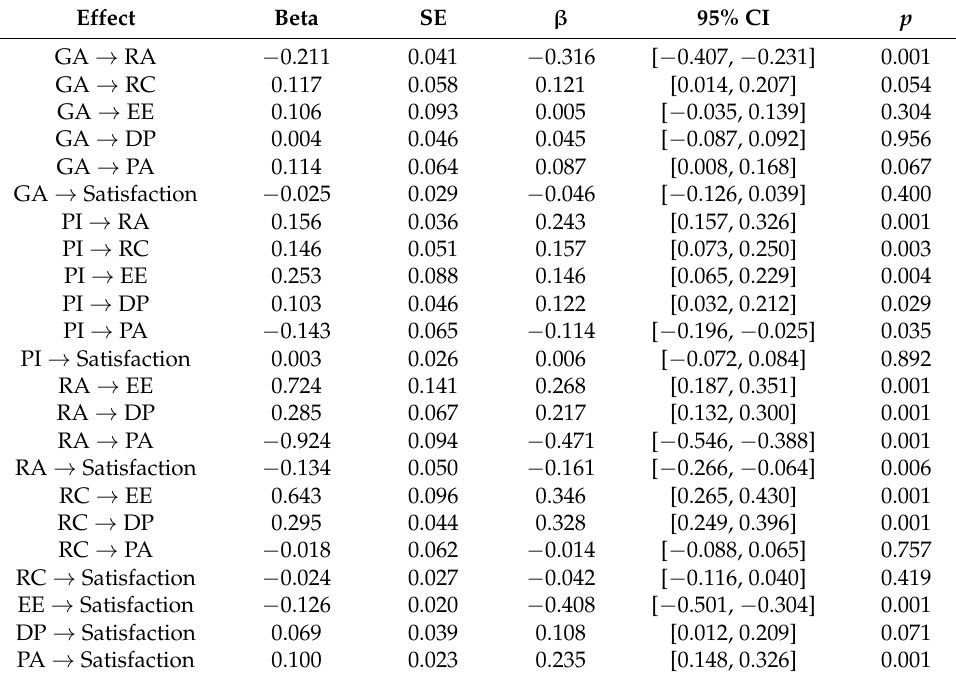
Table 2. Direct effects of predictor variables in the serial